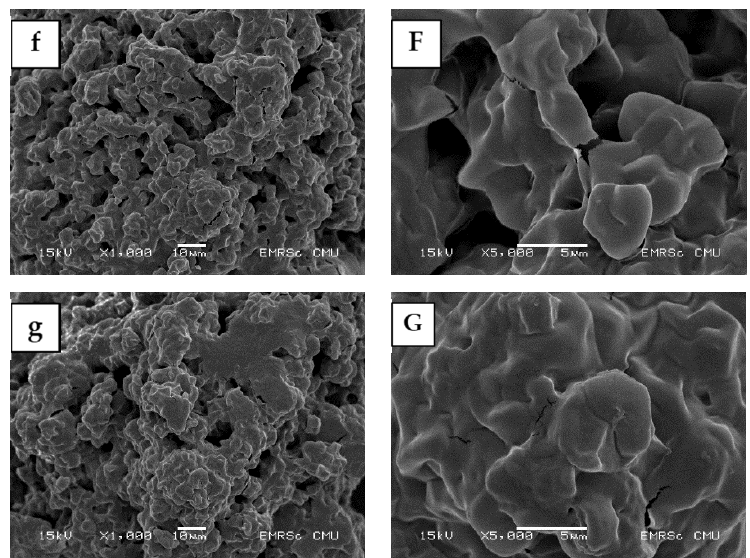
Figure 1. The SEM micrographs of ( a ) rice starch powder, and CMSr powders synthesized with ( b ) 10%, ( c ) 20%, ( d ) 30%, ( e ) 40%, ( f ) 50%, and ( g ) 60% NaOH concentrations at 1000× followed by ( A ) rice starch film, and CMSr film synthesized with ( B ) 10%, ( C ) 20%, ( D ) 30%, ( E ) 40%, ( F ) 50%, and ( G ) 60% NaOH concentrations at 5000×.